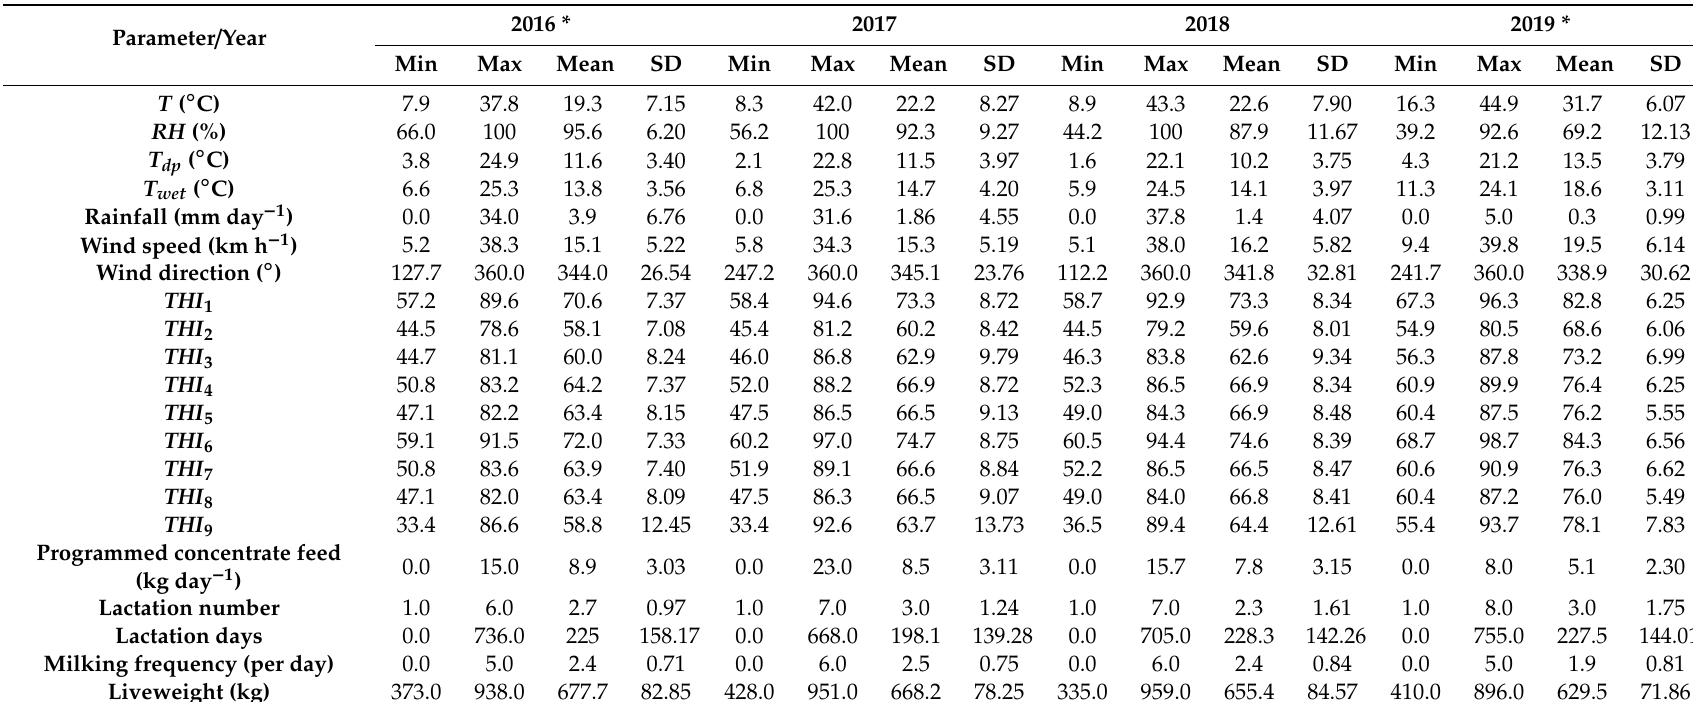
Table 1. Minimum, maximum, and mean values of the parameters used as inputs to develop the machine learning models. Parameter / Year